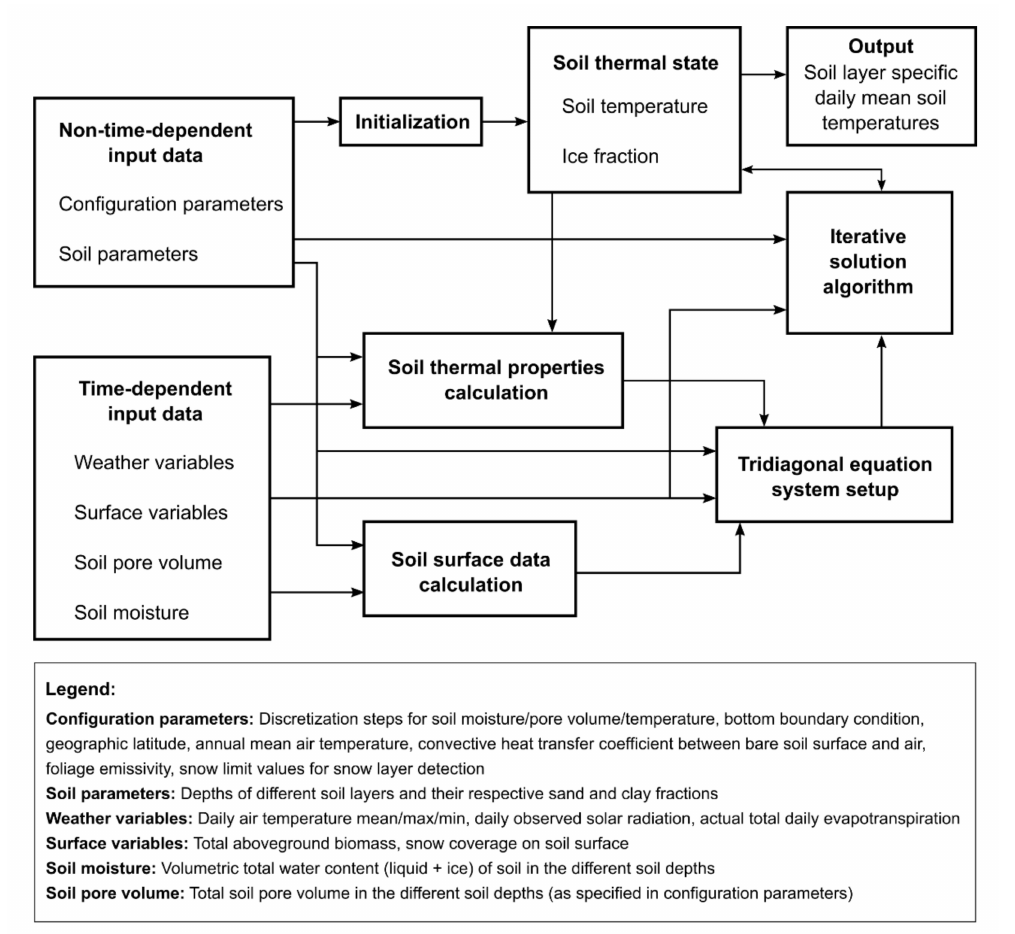
Figure 1. The AGRIcultural SOil TEmperature Simulation (AGRISOTES) model